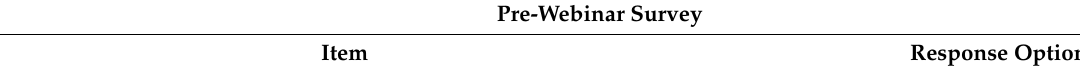
Table 1. Pre- and post-survey